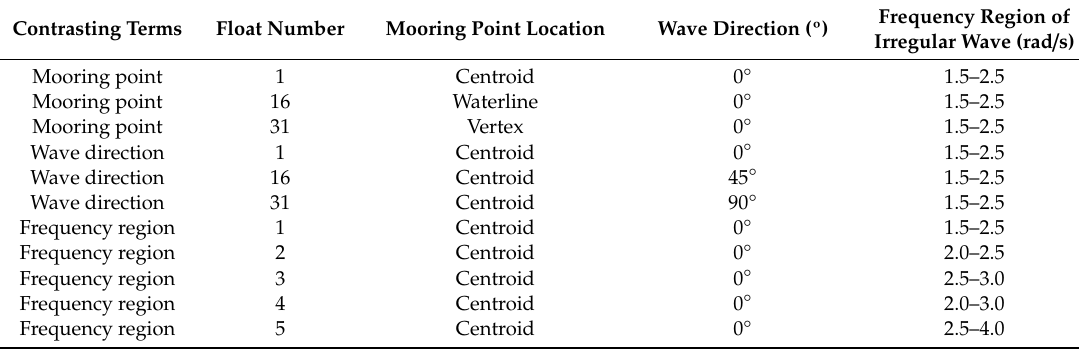
Table 2. Irregular wave combination